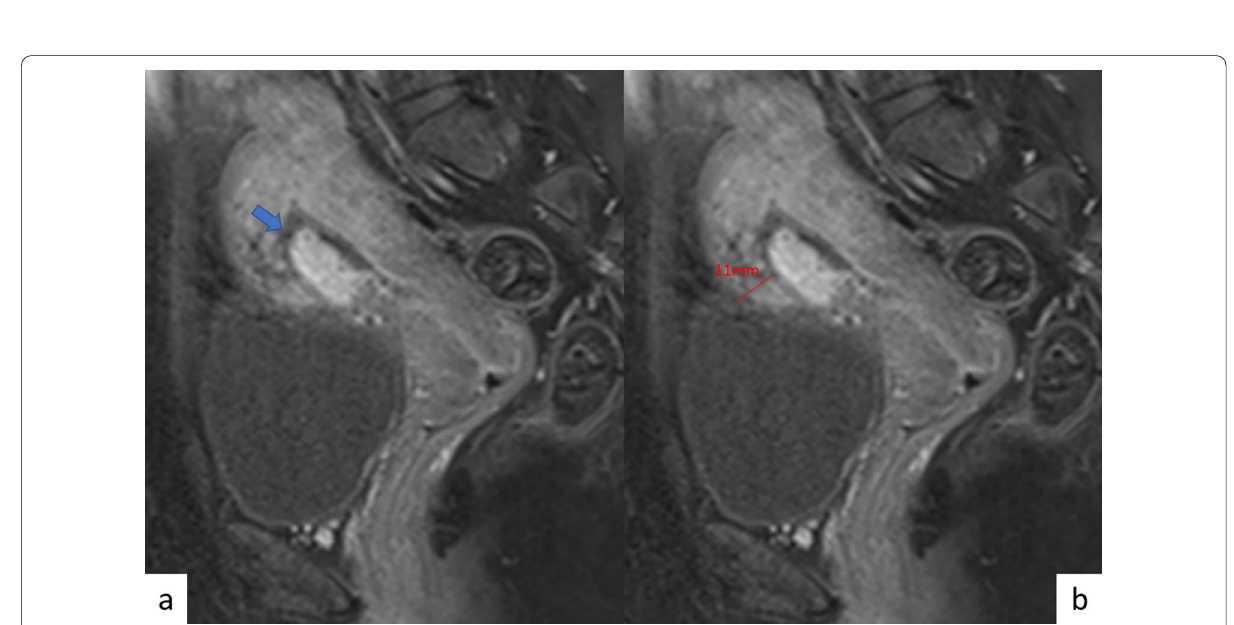
Fig. 4 a , b On post-contrast sagittal T1 WI, the lesion’s extension into the myometrium can be observed more clearly (blue